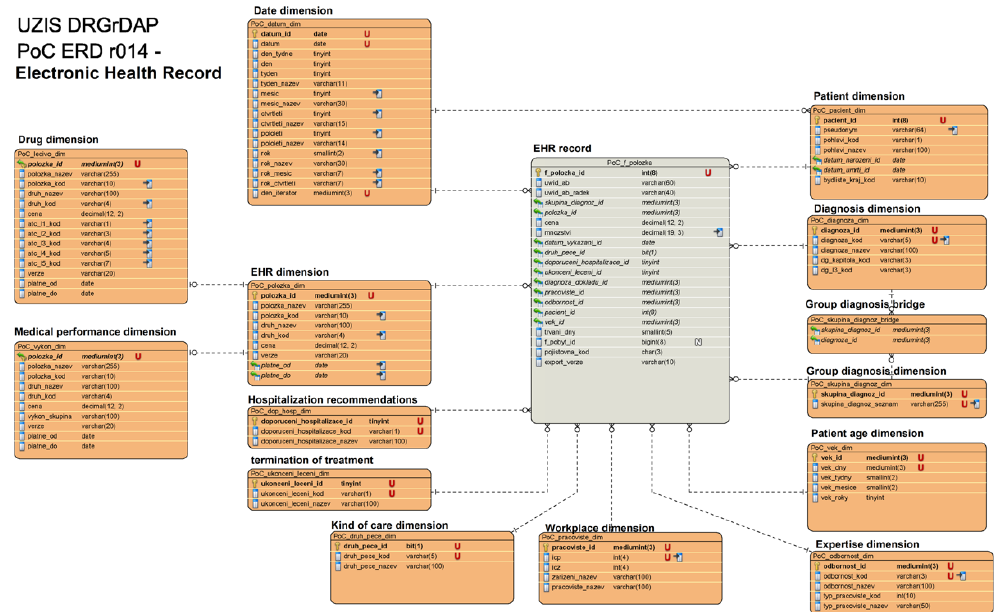
Figure A2. ER model of data warehouse for patient’s health record (part II). The provided figure is intended for online viewing in high resolution.